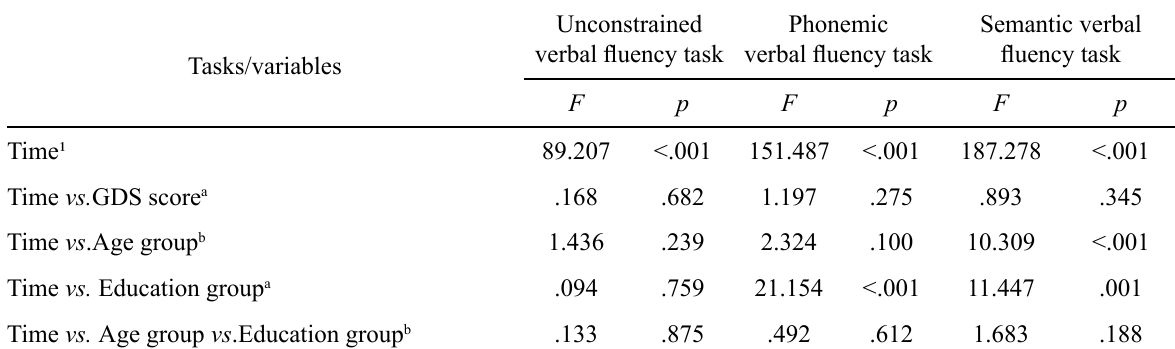
Table 5 Main Effects and Interactions Related to Performance thorough Time on the VFT (repeated measures ANOVA)